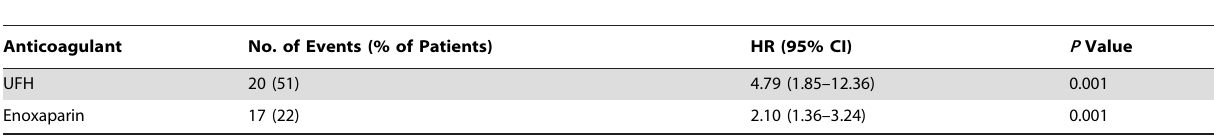
Table 4. Propensity adjusted hazard ratio of major bleeding events with the use of unfractionated heparin or enoxaparin.